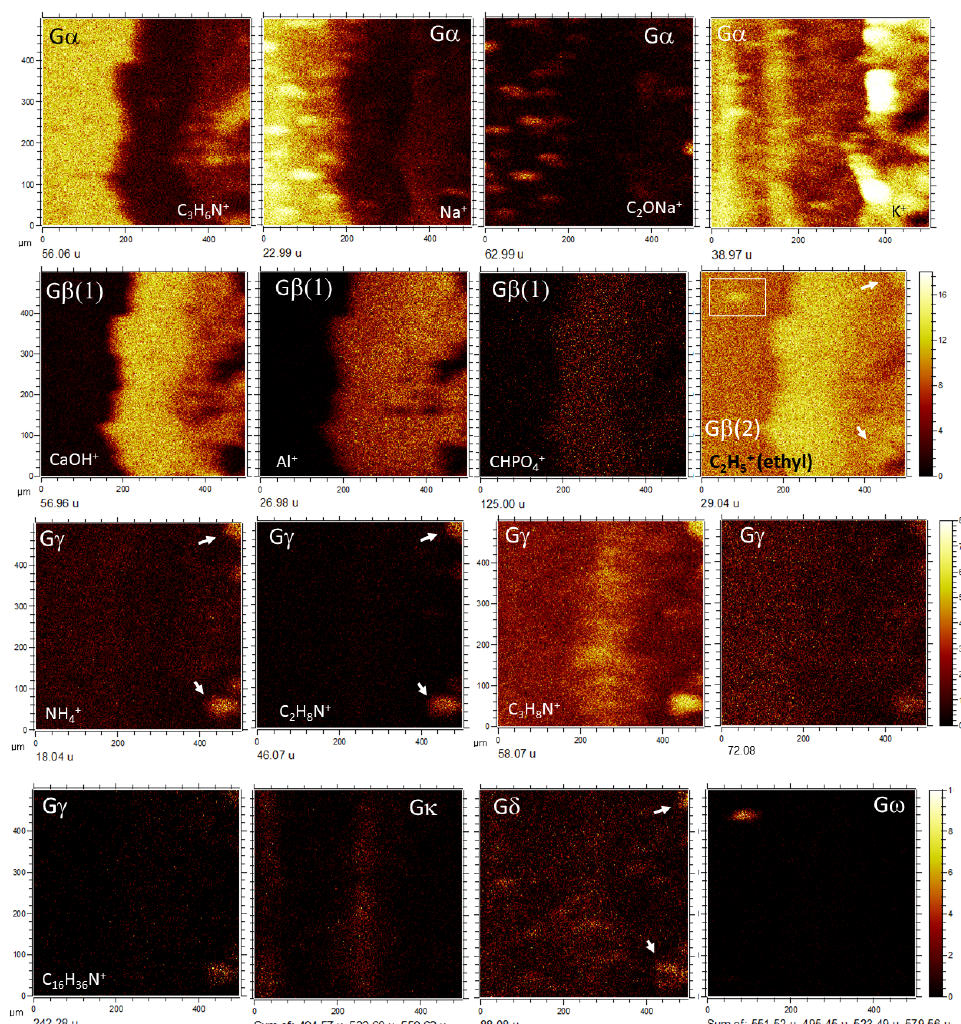
Figure 6. Characterization of the morphological groups by using the cation ToF-SIMS images in TA2. It has led to the identification of six different groups including G α , G β , G γ , G κ , G δ , and G ω . G α shows two variations that have been named G α (1) and G α (2) which are defined by the absence/presence of the nodular structures enriched in NH 4+ . The white arrows point to the nodular microstructures associated with NH 4+ and different N-bearing cations characterized as amino acids. K + and Na + classified as G α show a somewhat different distribution as they follow the occurrence of the filamentous-like microstructures crossing the glassy layer (ms in Figure 2b). Furthermore, K + also reveals the presence of two ~50 micron-sized lamina inside the glassy layer as well. It also has a high intensity in the phosphate-bearing patches. The white square points to an intensity increase in a very localized area that has been assigned to G ω . The ToF-SIMS images were obtained from a rasterized surface area of a 500 μ m square.